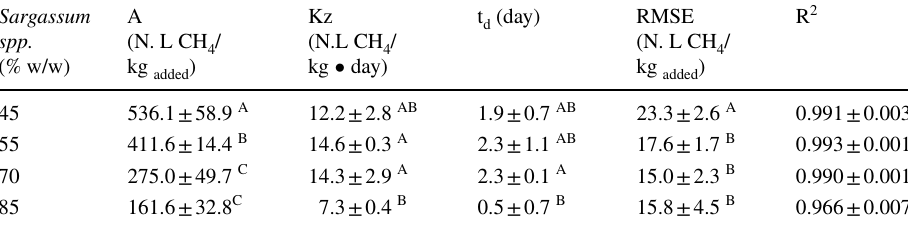
Table 4 Modified Gompertz model parameters estimated from the batch scale